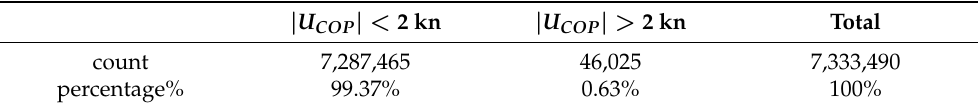
Table 13. Sea currents predicted speed U COP above and below 2 kn boundary.